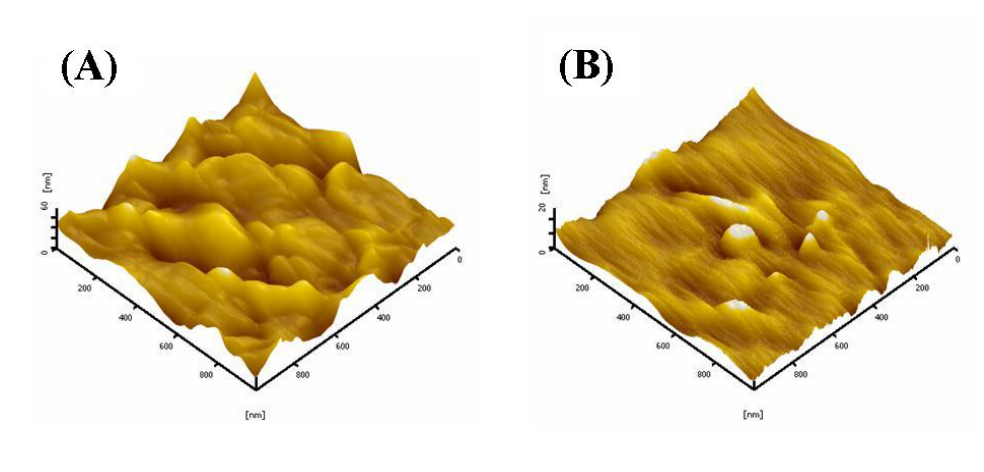
Figure 3. AFM images of 3a (A) and 3b (B); image sizes are 3 µm × 3 µm.